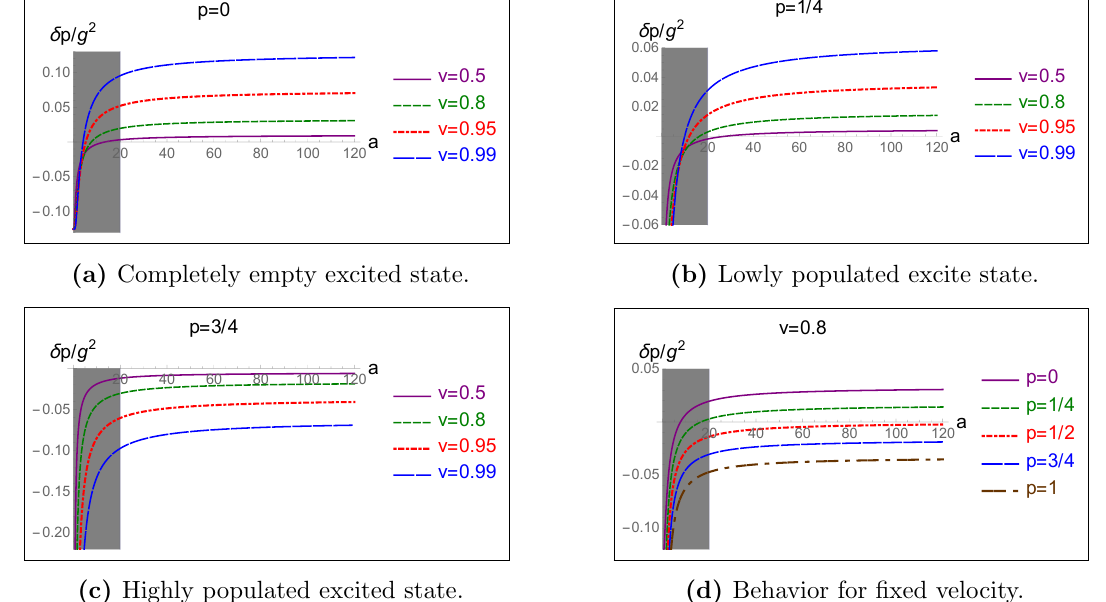
Figure 4. Behavior of the excited state population correction (cid:14)p as function of the reduced acceleration a = (cid:11)=!